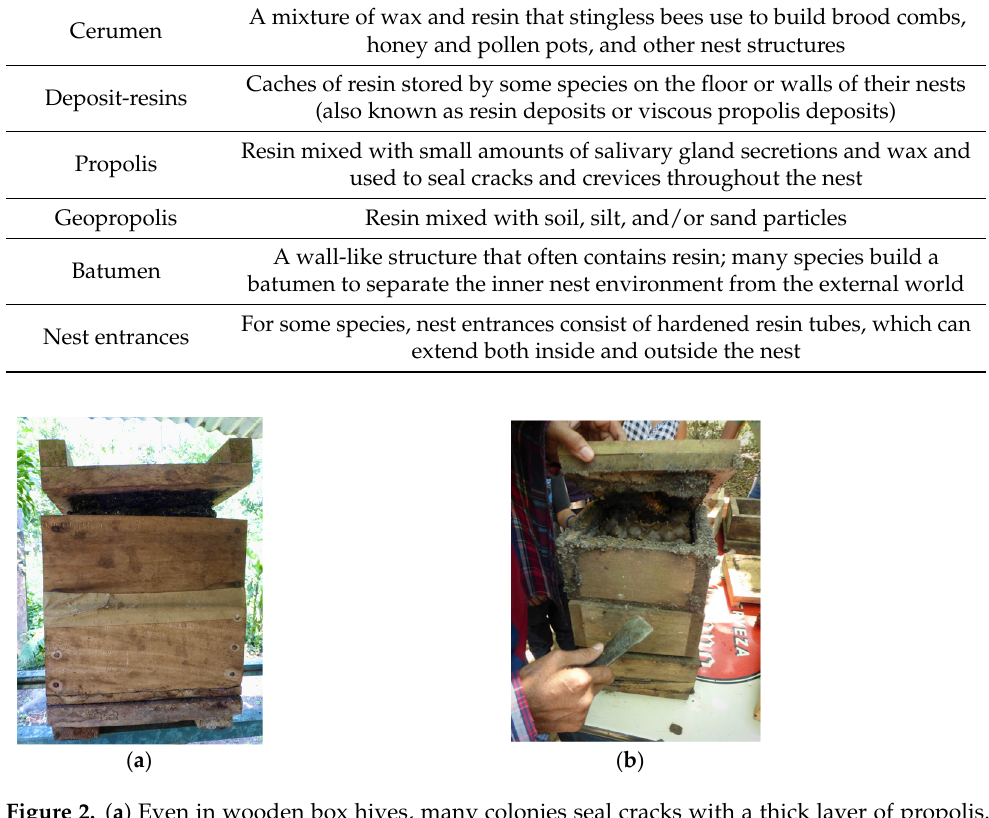
Table 1. Resin-rich materials and nest structures.